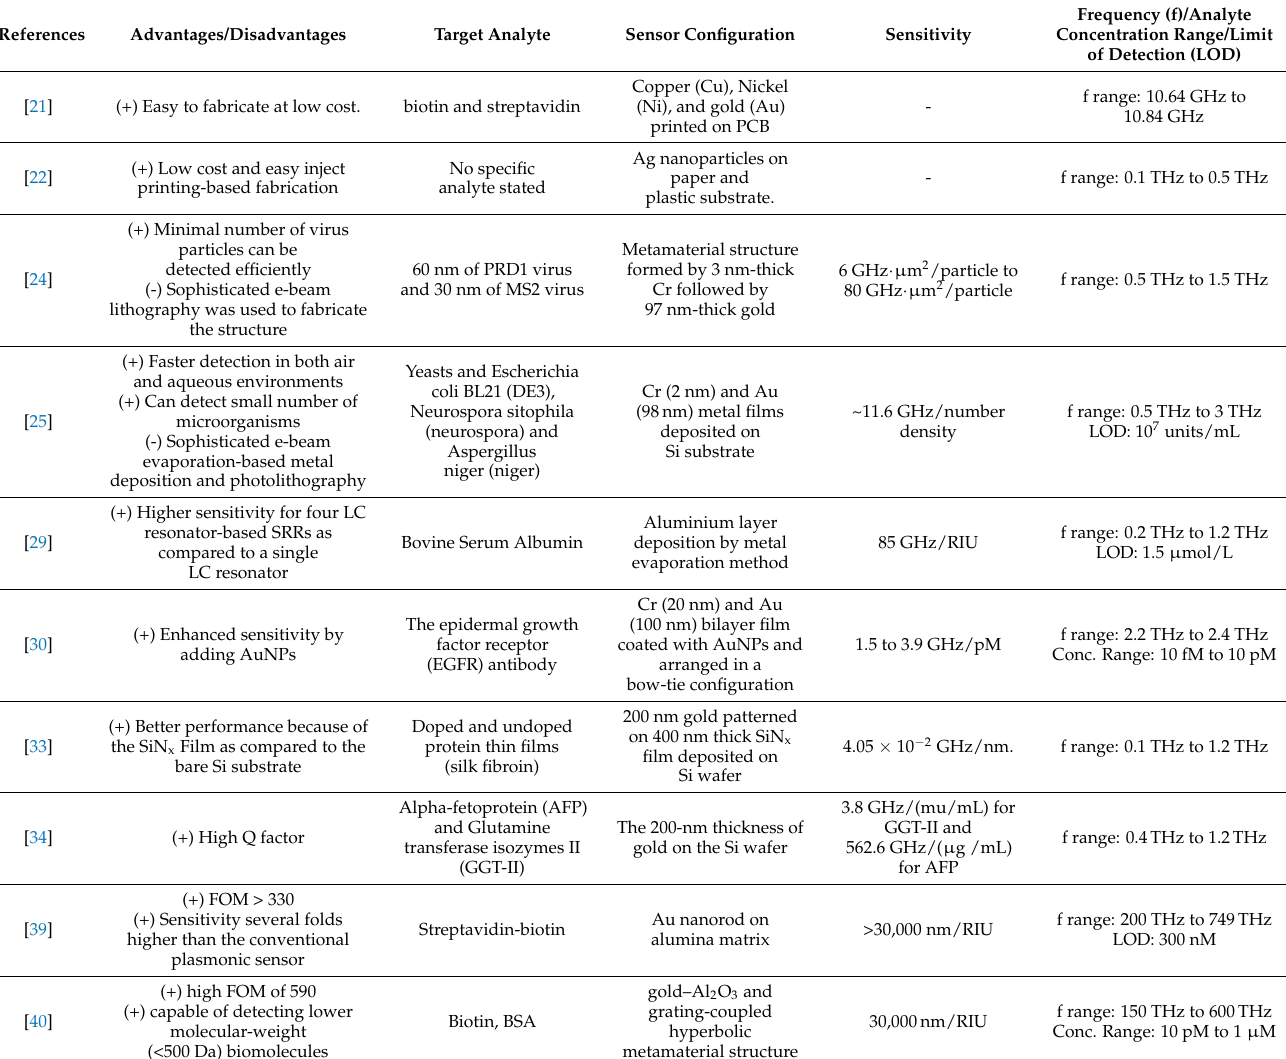
Table 1. Performance comparison of metamaterial-based